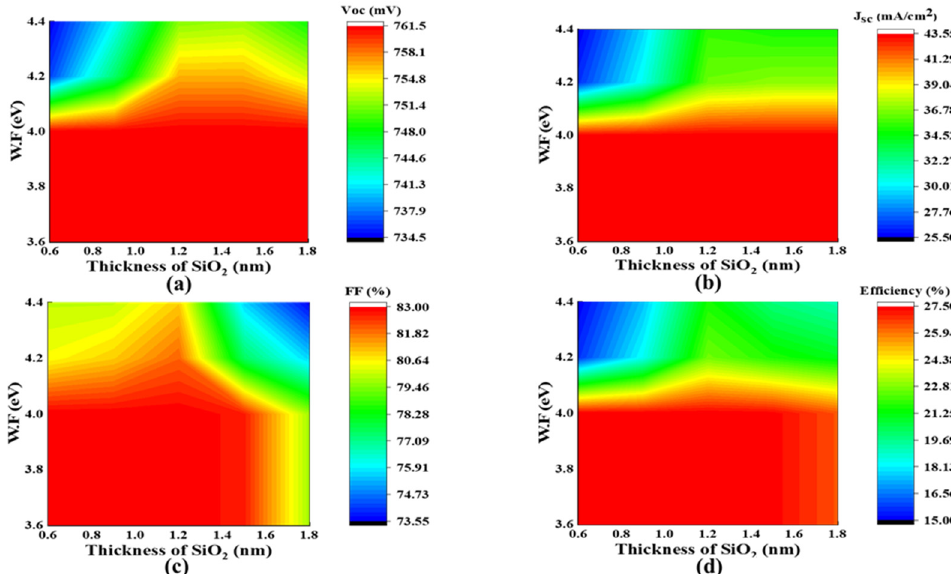
Figure 12. Effect of the oxide thickness (0.6–1.8 nm) and oxide work function (3.6–4.4 eV) on ( a ) V oc , ( b ) J sc, ( c ) FF, and ( d ) efficiency on the TOPCon solar cell.